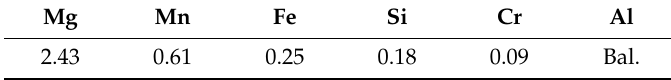
Table 1. Chemical composition of AA 5454 aluminum alloy